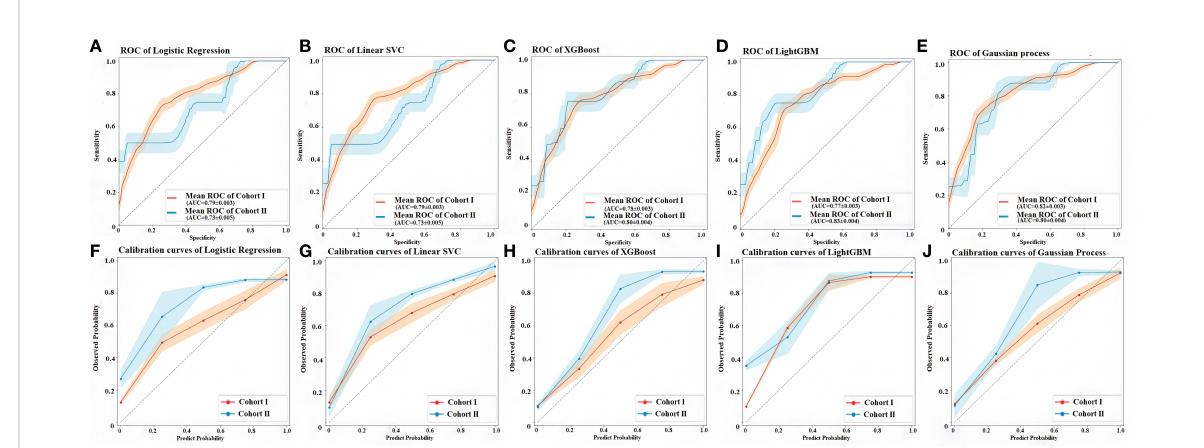
FIGURE 5 Discrimination and calibration performance of the 5 models. (A) ROC curves of the Logistic regression classi fi er in the cohort I and cohort II, respectively (AUC=0.788, 95% CI 0.785 – 0.790 versus 0.732, 95% CI 0.727 – 0.738). (B) ROC curves of the linear support vector machine classi fi er (Linear SVC) in the cohort I and cohort II, respectively (AUC=0.786, 95% CI 0.783 – 0.789 versus 0.736, 95% CI 0.731 – 0.741). (C) ROC curves of the in the extreme gradient boosting classi fi er (XGBoost) in the cohort I and cohort II, respectively (AUC = 0.781, 95% CI 0.778 – 0.784 versus 0.804, 95% CI 0.799 – 0.809). (D) ROC curves of the Light gradient boosting machine classi fi er (LightGBM) in the cohort I and cohort II, respectively (AUC = 0.766, 95% CI 0.763 – 0.769 versus 0.830, 95% CI 0.826 – 0.835). (E) ROC curves of the Gaussian process classi fi cation in the cohort I and cohort II, respectively (AUC = 0.816, 95% CI 0.813 – 0.819 versus 0.803, 95% CI 0.799 – 0.808). The light orange area and blue area represent the 95% CIs in cohort I and cohort II, respectively. 500 Bootstrap resamples were used to calculate a relatively corrected AUC and 95% CI. Calibration curves of fi ve models in the cohort I and cohort II are shown in fi gures from (F – J) The 45° dashed line represents a perfect prediction, the orange lines represent the predictive performance of the model in the cohort I, and the blue lines represent the predictive performance of the model in the cohort II. The closer the dotted line to the ideal line, the better the predictive accuracy of the model is (56). AUC, area under the curve; CI, con fi dence interval; ROC, receiver operating